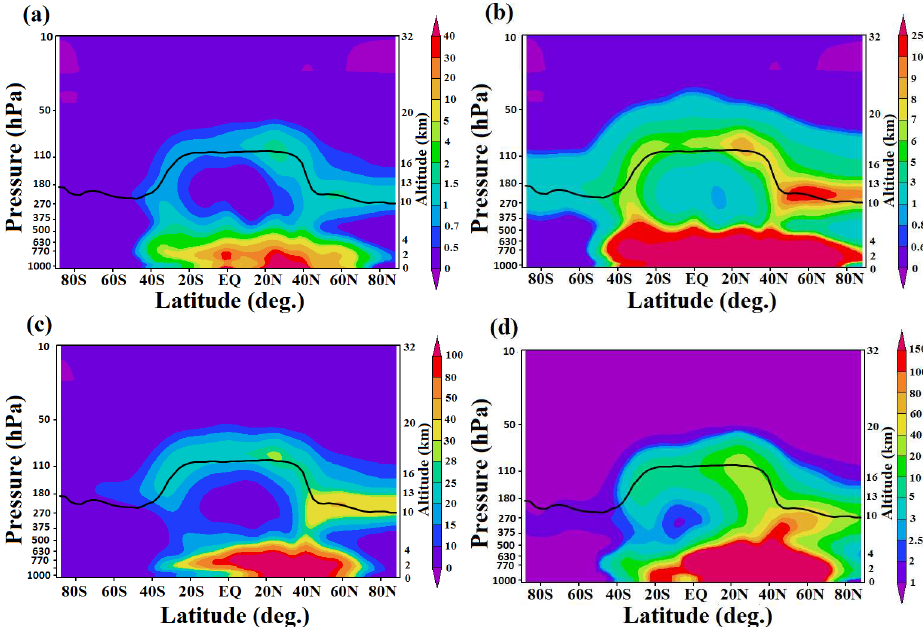
Fig. 3. “cross section” (averaged for June–September and 60–120 ◦ E) of concentrations (ngm − 3 ) of (a) BC aerosols, (b) OC aerosols, (c) SO 2 − aerosols, and (d) mineral dust aerosols. The black line marks the longitudinally averaged tropopause showing increased height in the 4 ASM